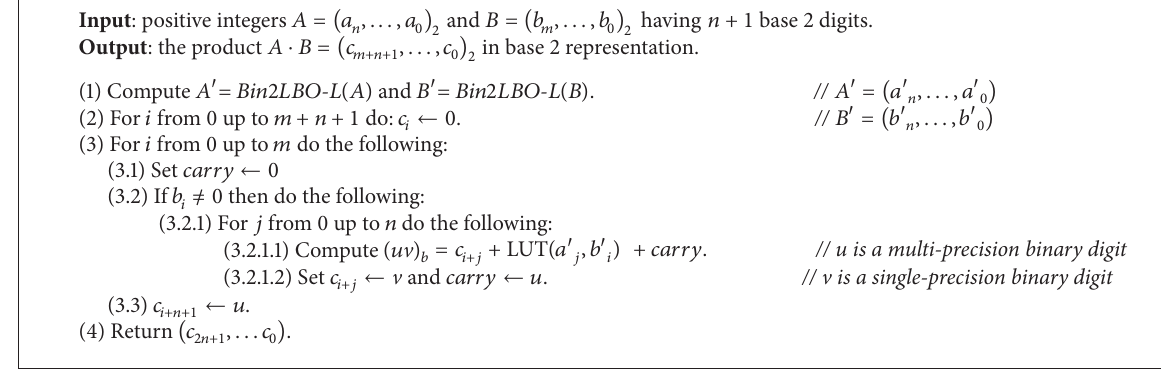
Algorithm 8: Multiple-precision classical multiplication, BOCM (𝐴, 𝐵)